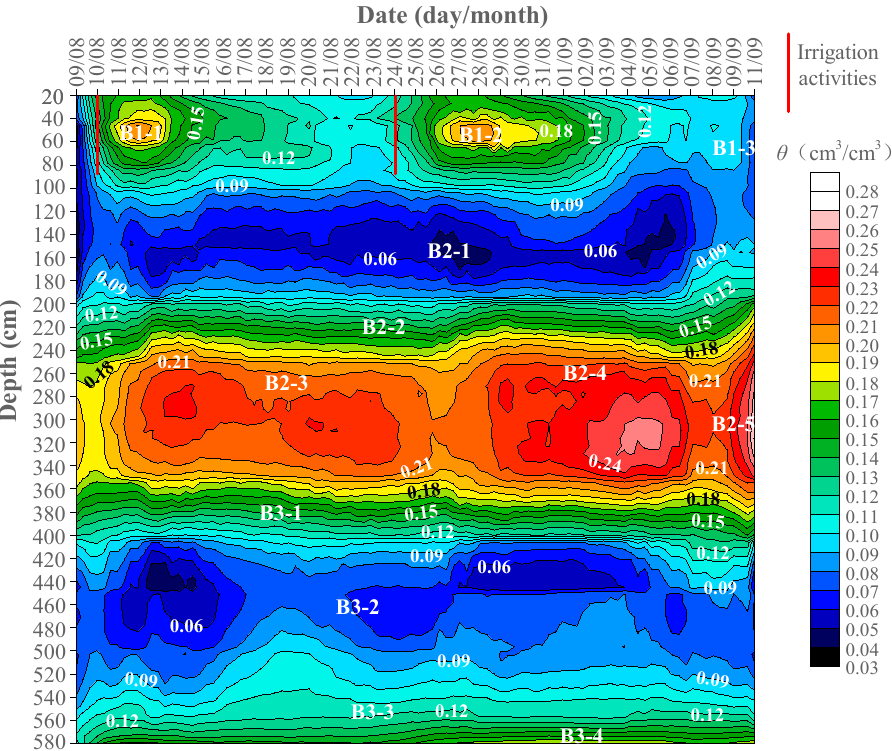
Figure 8. The soil moisture isogram of time and depth at point 9 with the crop of corn.